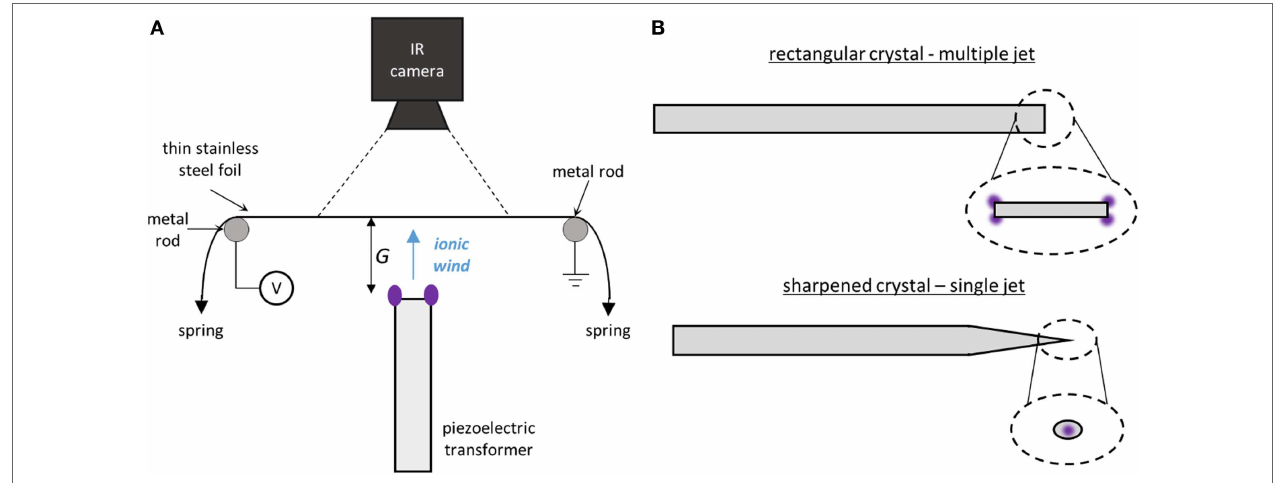
FIGURE 2 | (A) A schematic showing the apparatus used to measure the impingement cooling properties of the PT-driven ionic wind. The thin stainless steel plate was resistively heated by a differential voltage applied between the two metal rods. The total heated area of the plate was 8cm (cid:2) 12cm. The side of the plate facing the IR camera was painted black to improve IR measurements. (B) A schematic depicting the two different shapes of piezoelectric crystals used to cool the plate. The single jet crystal had one of its ends sharpened to a point so a single jet was generated. The insets show the view along the axis of the PT.